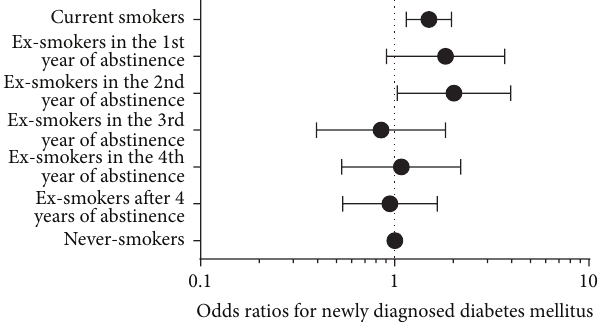
Figure 1: The comparison of the odds ratios for the incidence of newly diagnosed diabetes mellitus by smoking status. With never-smokers as reference (OR = 1), current smokers and ex- smokers in the first and second year of abstinence were inclined to have newly diagnosed diabetes mellitus, though the increased odds ratio for ex-smokers in the first year of abstinence was not statistically significant. All odds ratios were adjusted for age, alcohol consumption, abdominal obesity, high BP, dyslipidemia and impaired fasting glucose at their first examination, and weight gain between the first and the final